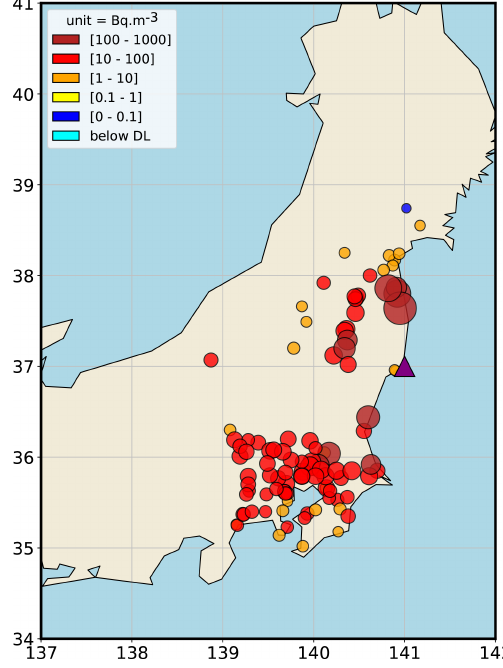
Figure 1. Maximum air concentrations of 137 Cs (in Bqm − 3 ) mea- sured in Japan in March 2011. The light blue points correspond to concentrations below the detection limit. The purple triangle corre- sponds to the Fukushima Daiichi